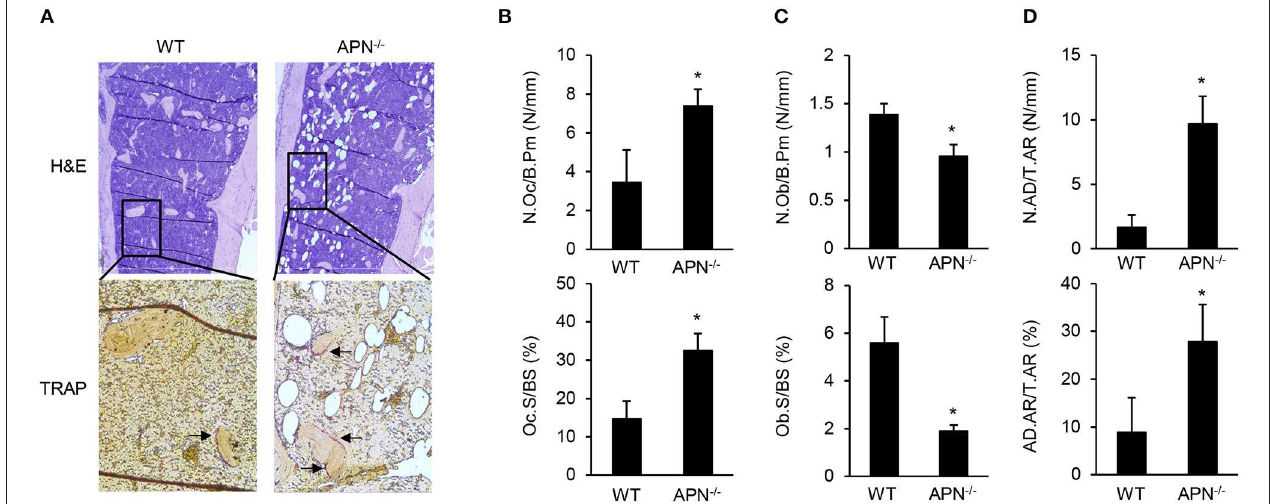
FIGURE 2 | Adiponectin-deficient mice have reduced bone mass but increased adiposity. (A) Paraffin sections of the femur were stained with H&E or for TRAP (magnification, upper panel: × 100, lower panel: × 400). One of three similar results is shown. Histomorphometric analysis was performed for parameters related to (B) bone resorption, (C) bone formation, and (D) adiposity formation using Osteomeasure software. The parameters were measured with average of 15 fields of each bone ( n = 3 per group). The arrows indicate TRAP-positive region. N.Oc/B.Pm, osteoclast number per bone perimeter; Oc.S/BS, osteoclast surface per bone surface; N.Ob/B.Pm, osteoblast number per bone perimeters; Ob.S/BS, osteoblast surface per bone surface; N.AD/T.Ar, adipocyte number per tissue areas; AD.Ar/T.Ar, adipocyte area/tissue areas. Data shown are the mean values ± SD of triplicate samples and are representative of three similar independent experiments. * P < 0.05 compared with the wild-type